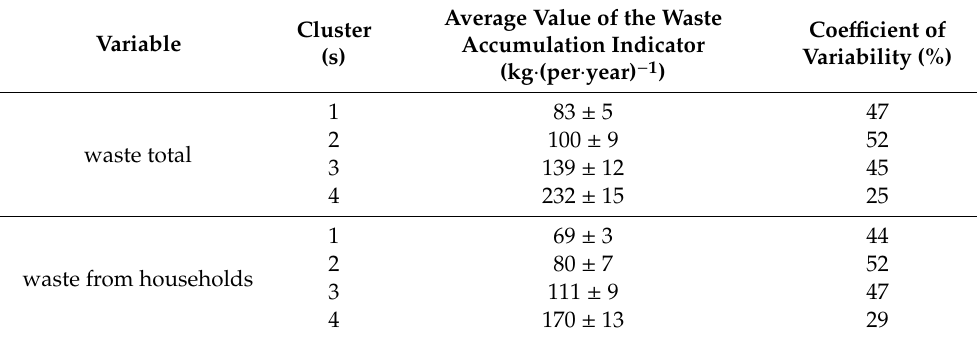
Table 5. Description of the waste accumulation indicator for individual clusters.